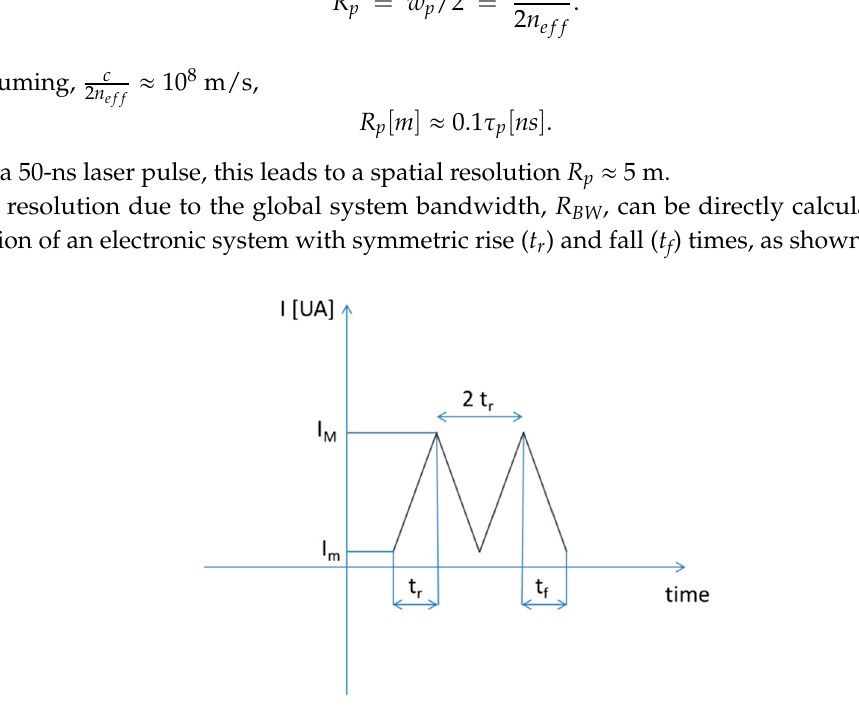
Figure 6. Representation for spatial resolution calculation due to bandwidth. The graph shows the hypothetical backscattered optical signal received by the photodiode, assuming two consecutive events. The system resolution is, in the time scale, equal to 2 t r , where we assume that the system has a symmetric response, i.e., similar rise and fall times ( t r = t f ).